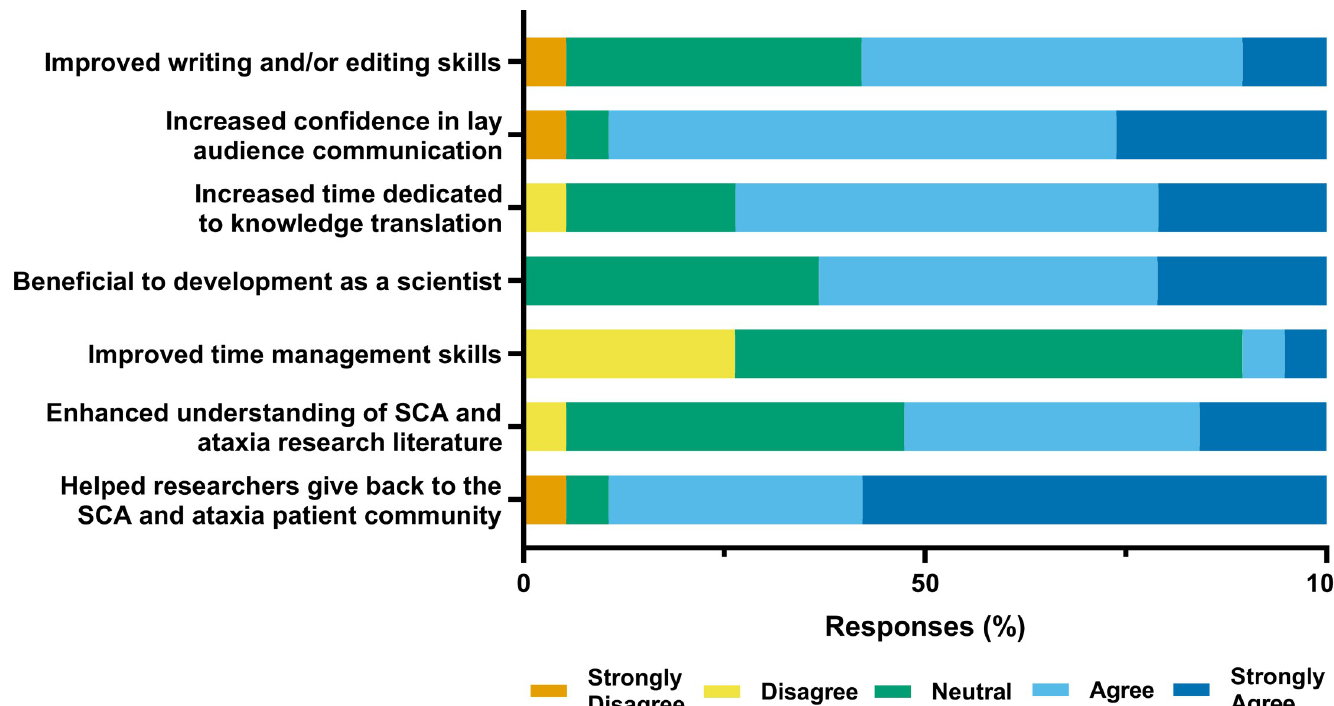
Fig 2. Contributors self-reported outcomes of volunteering for SCAsource. Respondents were asked to rate their agreement about whether volunteering for SCAsource resulted in the above statements using the indicated 5-point Likert-type scale.